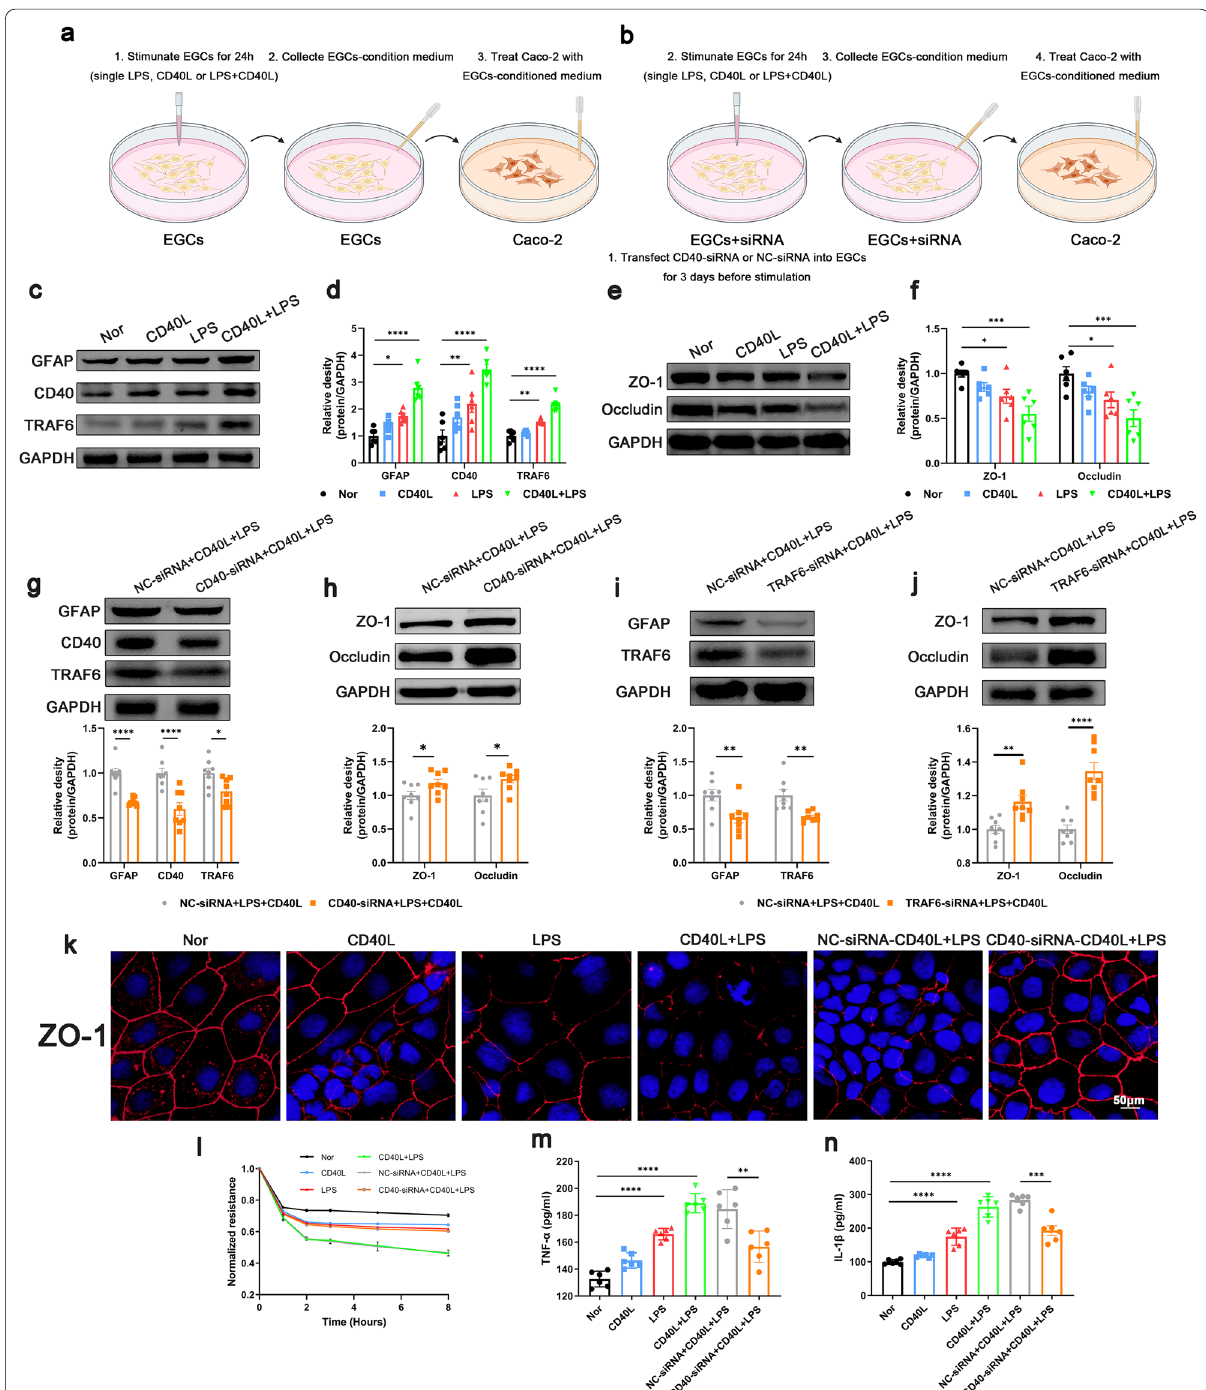
Fig. 4 Effect of CD40L–CD40–TRAF6 signaling on EGCs in vitro. a , b Primary EGCs were stimulated with LPS, CD40L alone or LPS siRNA transfection and the EGCs-conditioned medium were collected for Caco-2 culture. Western blot analysis of GFAP, CD40 and TRAF6 expression in EGCs ( c , d , g , i ), ZO-1 and occludin expression in Caco-2 cells ( e , f , h , j ) (n 6). k Immunofluorescence staining analysis of ZO-1 (red), Scale = bar 50 μm. l Transepithelial electrical resistance (n 3). TNF-α ( m ) and IL-1β ( n ) levels in EGCs-conditioned medium (n = = as the mean SEM, * P < 0.05, ** P < 0.01, *** P < 0.001, **** P < ±